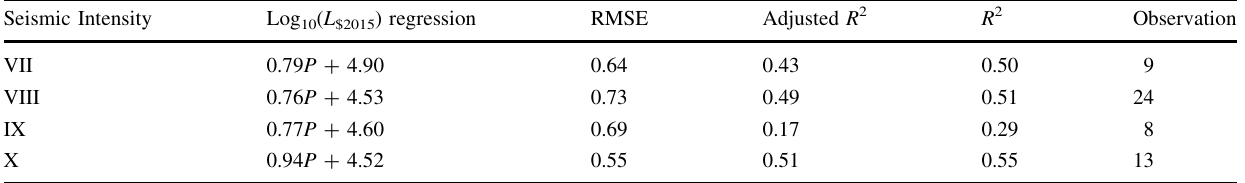
Table 4 Regression of the economic losses adjusted to 2015 USD value ( L $2015 ) considering POP.Unit as the exposure-related variable for seismic intensities between VII and X Seismic Intensity